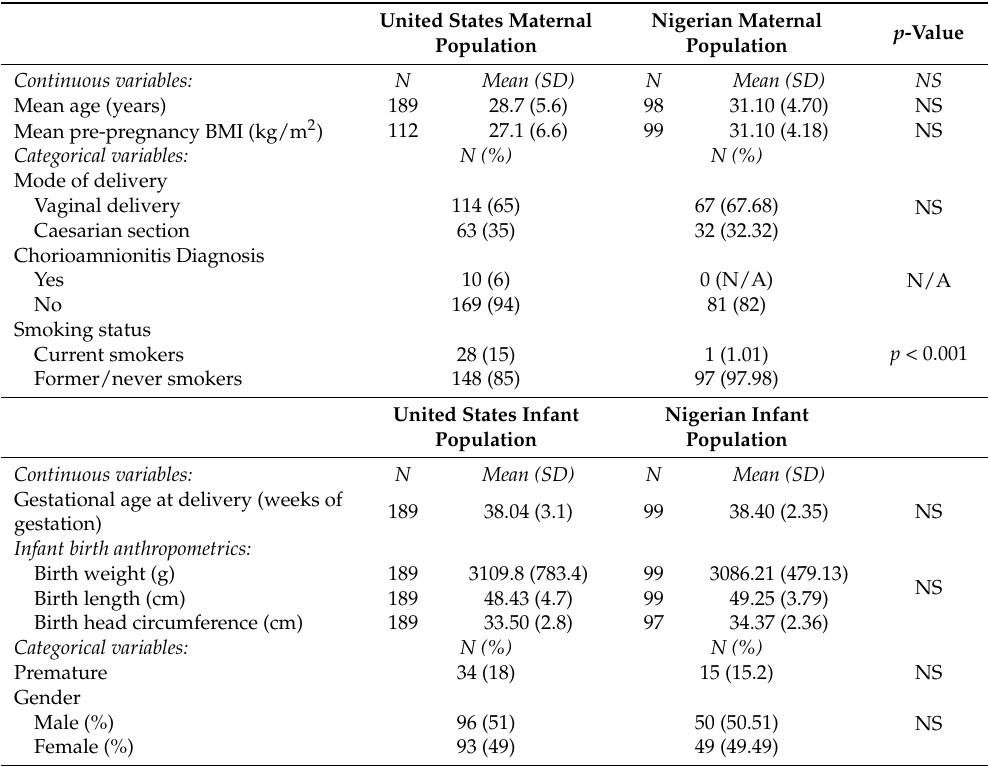
Table 1. Maternal and infant